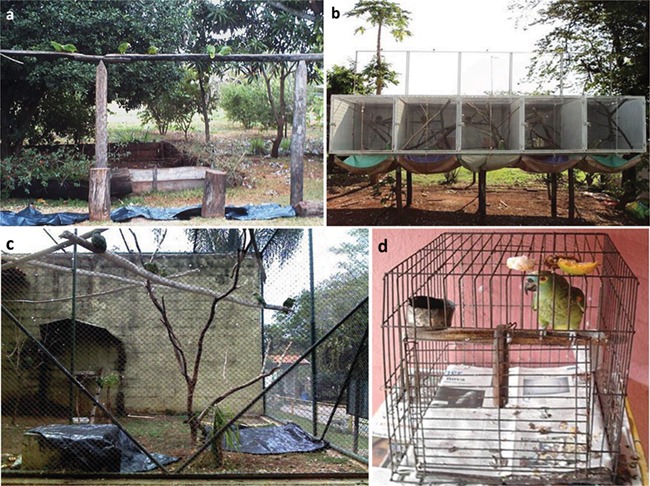
The husbandry systems used in the study. (a) Free-living Blue-fronted parrots in collective feeders in the Fazenda São Francisco, Pantanal region; (b) pair-housed parrots in suspended breeding aviaries at the Brisa commercial breeder; (c) Blue-fronted parrot enclosure at the Municipal Zoo of Piracicaba (São Paulo) with the plastic tarpaulins; (d) example of an A. aestiva individual living as pets in a private house.